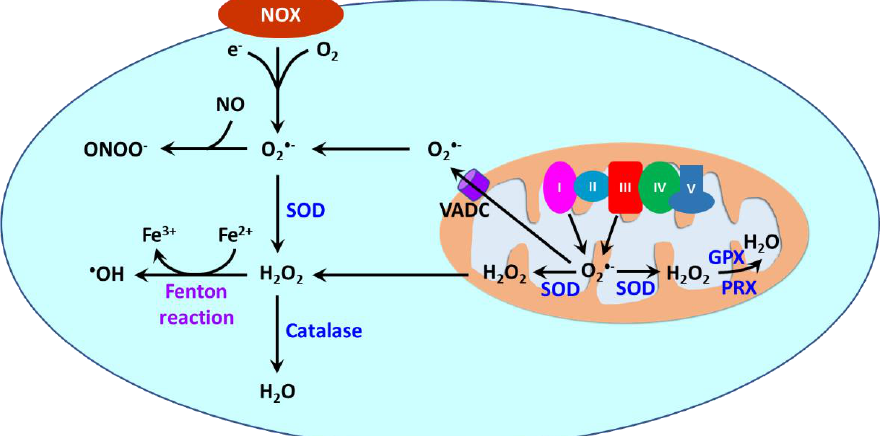
Figure 3. ROS generation by NOXs and mitochondria and detoxification. In vascular smooth muscle cells, ROS is primarily produced by NOXs and mitochondria. NOXs catalyze the production of O 2 •−